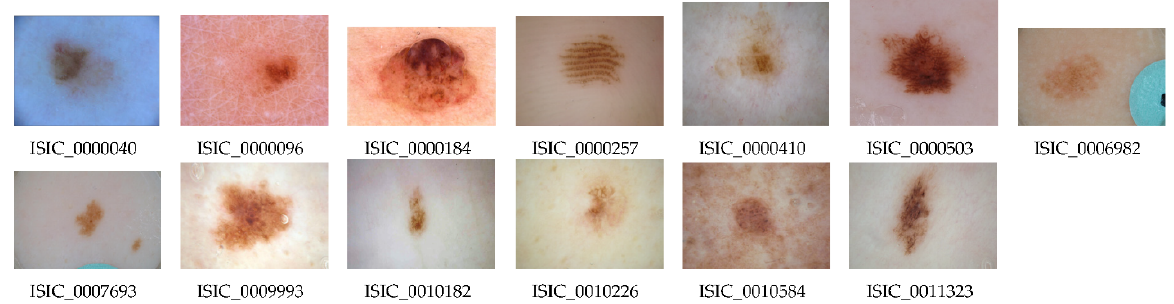
Figure 7. Image dataset sNH-data selected randomly from NH-data .